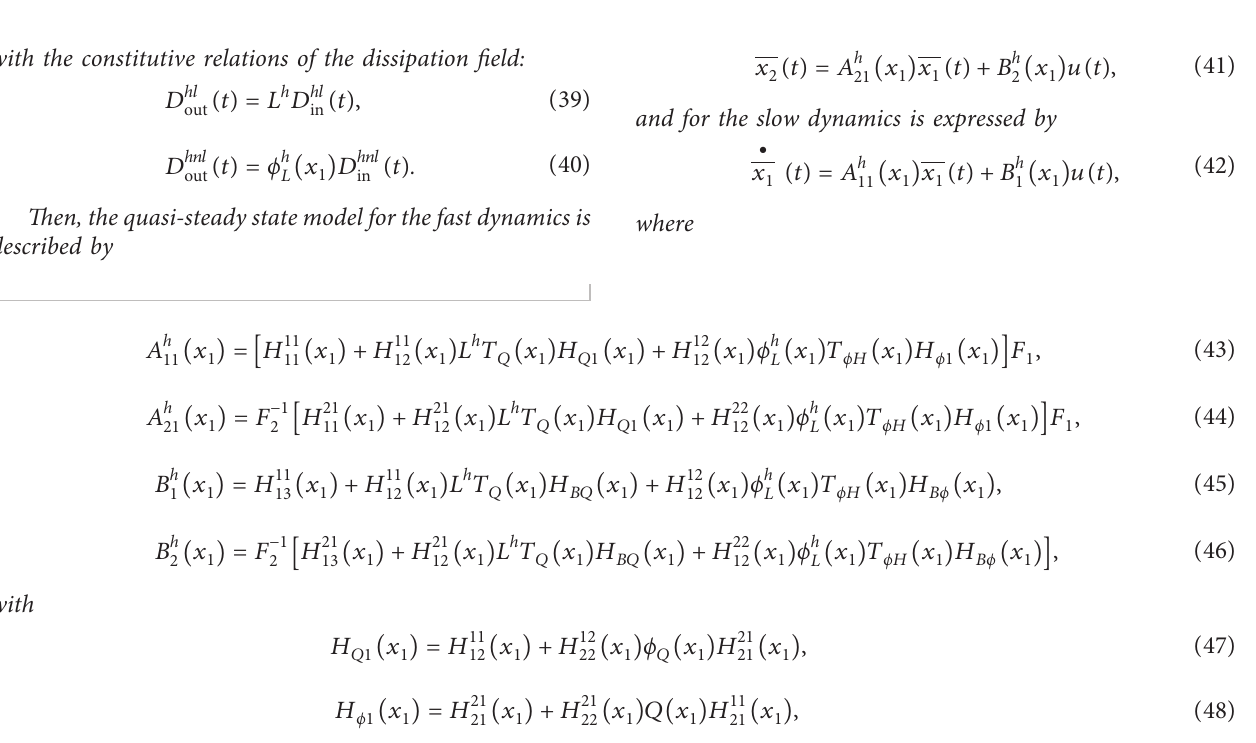
Figure 3: Bond graph of a class of nonlinear systems with integral and derivative causality for slow and fast dynamics,